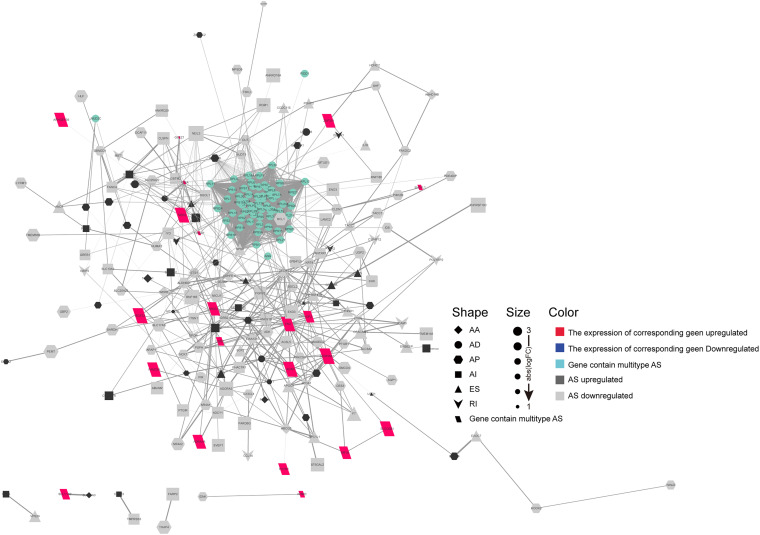
Protein–protein interaction (PPI) analysis of the identified differentially expressed alternative splicing (DEAS). Interactions of the 372 parent genes affected by DEAS. These genes were used to construct an intricate PPI network comprising 249 nodes and 514 edges. The genes are denoted as nodes in the graph, and the interactions between them are represented as edges. The shape, size, and color of the nodes, respectively, represent alternative splicing type, value of log(FC), and change pattern.